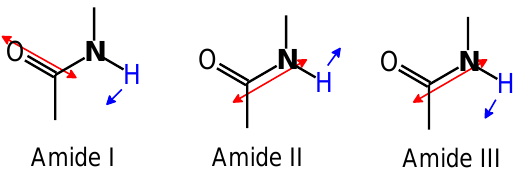
Figure 4. Vibrational modes of Amide I, Amide II, and Amide III.